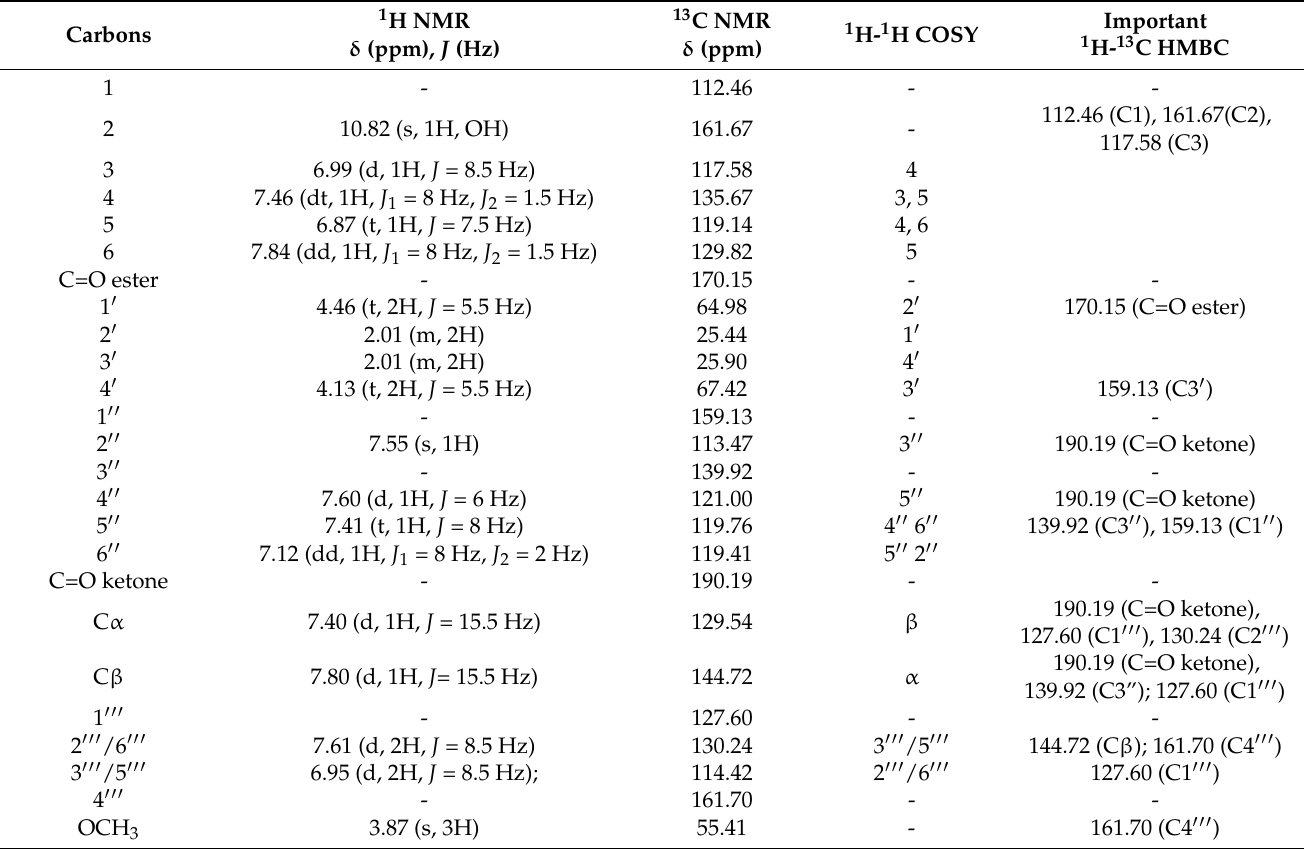
Table 1. The 1D and 2D NMR spectra interpretations of the title compound.